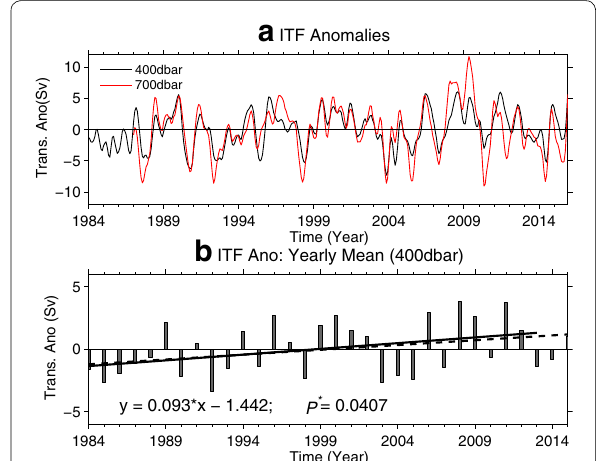
Fig. 2 The ITF transport anomalies estimated by IX1 XBT data. a Monthly time series of the ITF transport anomalies estimated by IX1 XBT temperatue records and monthly T–S relationship, with reference depths of 400 and 700 m, respectively, from January 1984 to Decem- ber 2015. b Annual mean ITF transport anomalies with a reference depth of 400 dbar, and their linear trends during 1984–2013 (Liu et al. 2015), and during 1984–2015. The linear regression coefficients and 95% significance test are for the 1984–2013